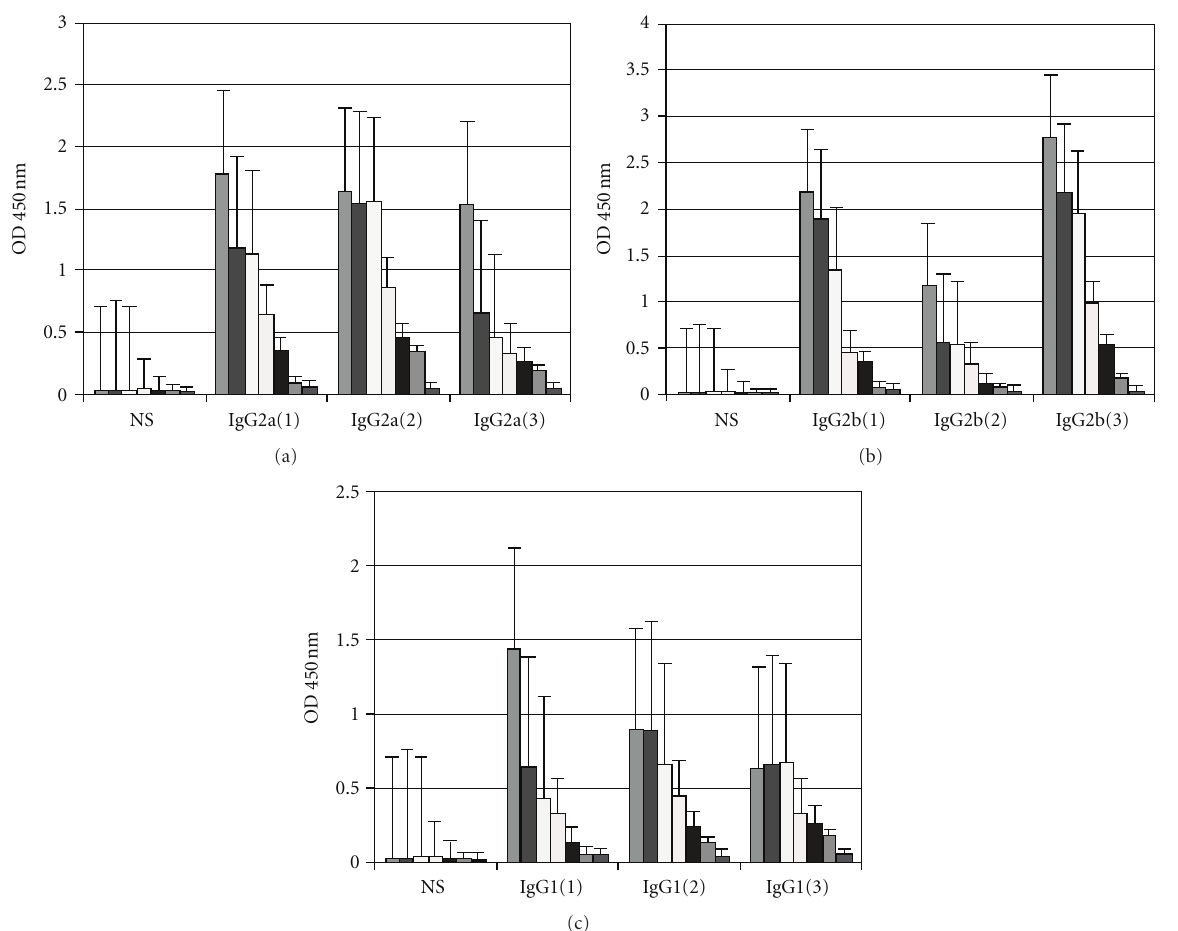
Figure 5: Level of IgG1, IgG2a, and IgG2b antibodies present, determined by ELISA, in mouse sera of BALB/c immunized with (a) OMPs of N. meningitidis and stx1 (b) OMPs of N. meningitidis and stx2 and (c) CT, at 42 days, 7 days post the i.m prime-boost. NS: normal mouse sera as control. Each scale bar represents the mean ± SE of nine to ten mice per group per group in an experiment representative of two separate. (a) OMPs and stx1-IgG1, IgG2a, and IgG2b containing formulations versus normal sera ( P < 0 . 001). (b) OMPs and stx2 IgG1, IgG2a, and IgG2b containing formulations versus normal sera ( P < 0 . 001). (c) OMPs and CT IgG1, IgG2a, and IgG2b containing formulations versus normal sera ( P < 0 .